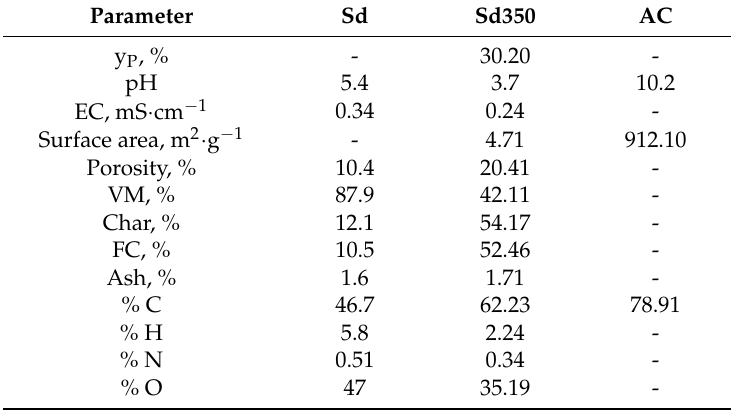
Table 1. Characterization of the raw materials and biochar sawdust subjected to slow pyrolysis